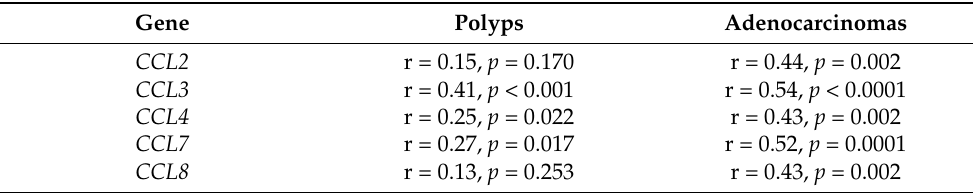
Data presented as Pearson’s correlation coefficients